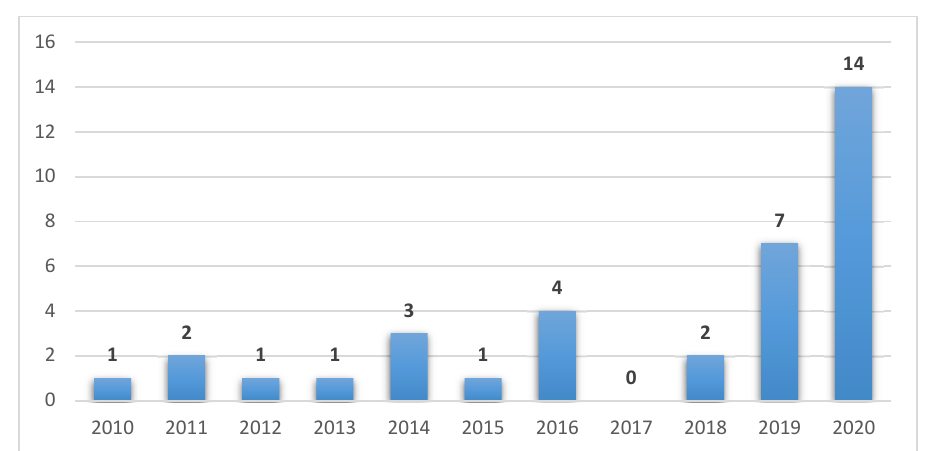
Fig. 13. A classification for objectives of HFSPs